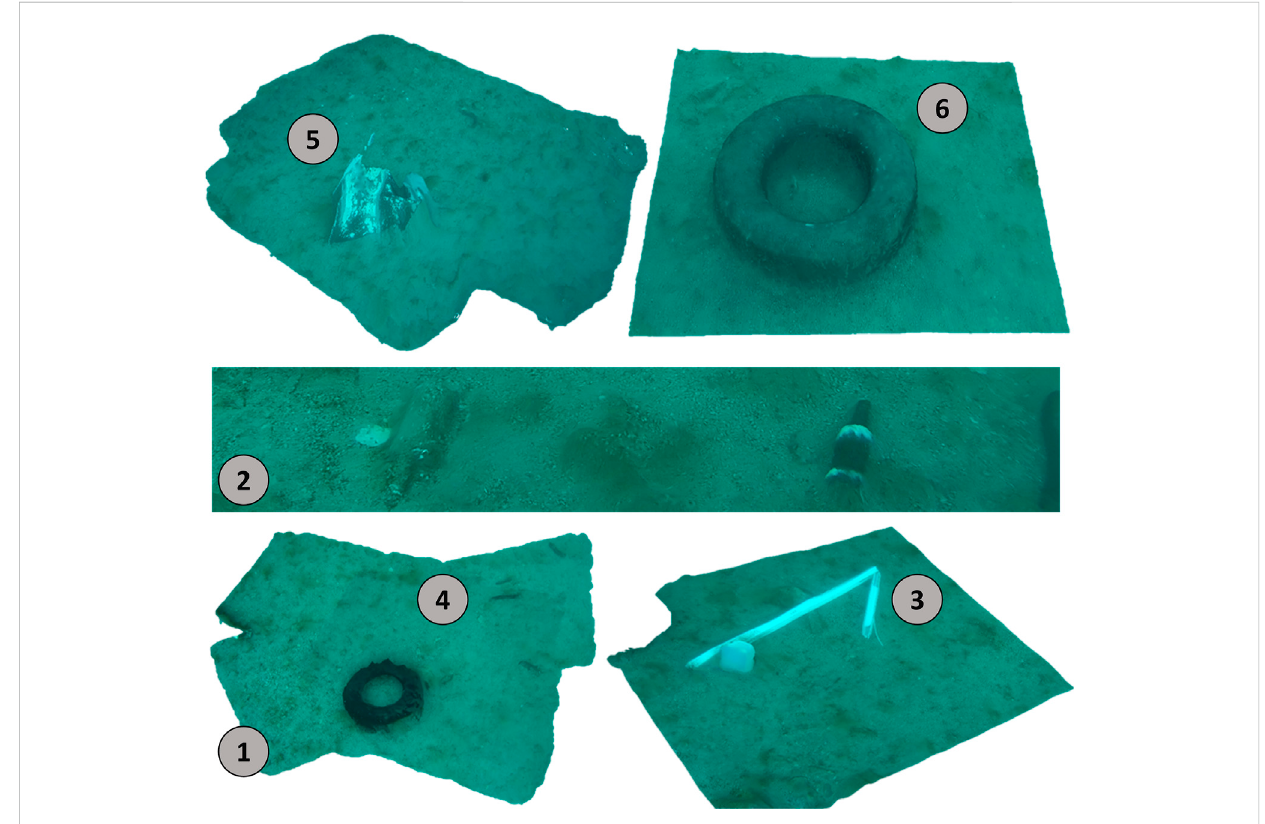
FIGURE 5 Detected marine litter on the sea fl oor using ROV.